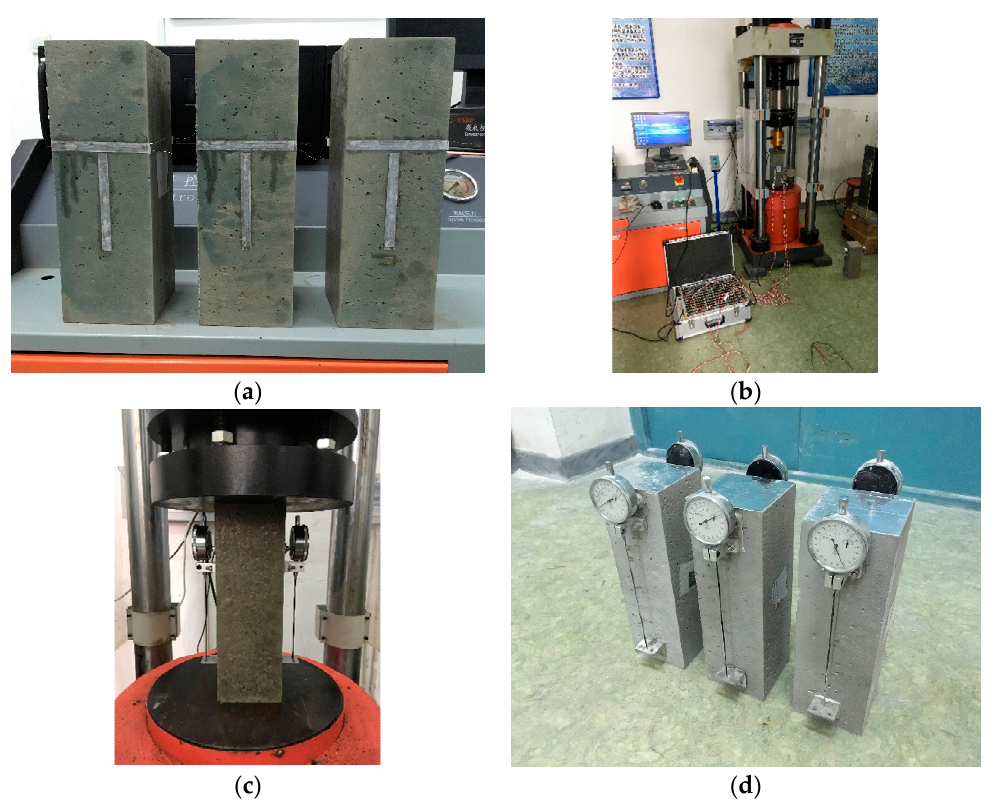
Figure 2. Tests on compressive strength, elastic modulus and shrinkage: ( a ) samples used for compressive strength; ( b ) compressive test; ( c ) elastic modulus test; ( d ) shrinkage test.